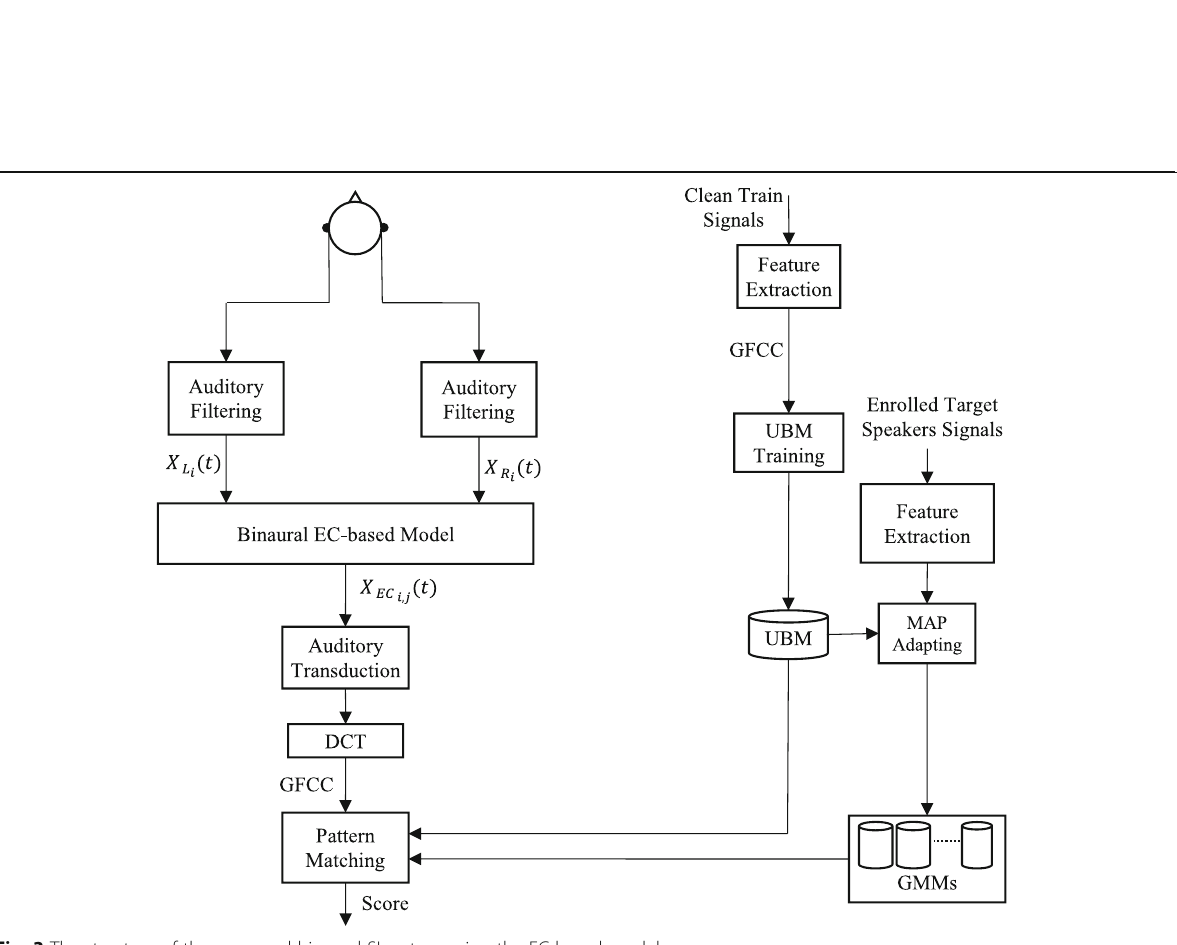
Fig. 3 The structure of the proposed binaural SI system using the EC-based model